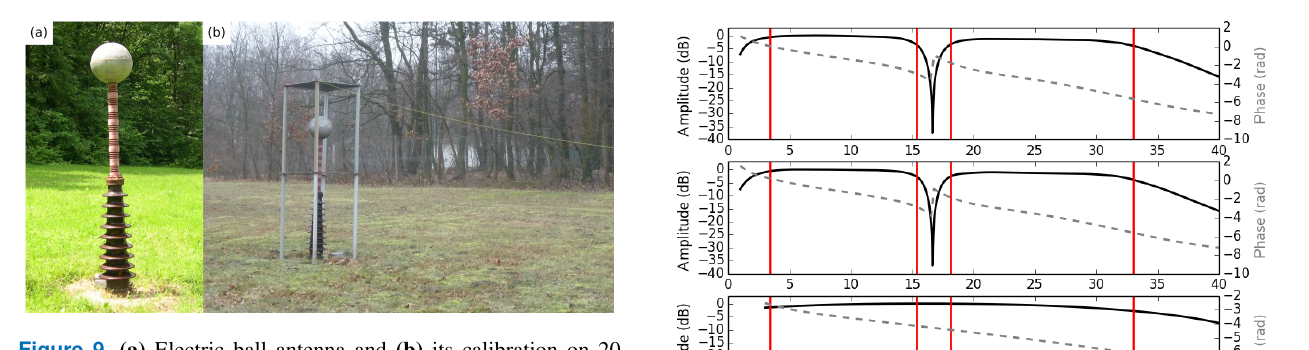
Figure 9. (a) Electric ball antenna and (b) its calibration on 20 December, 2013 in the Széchenyi István Geophysical Observatory.